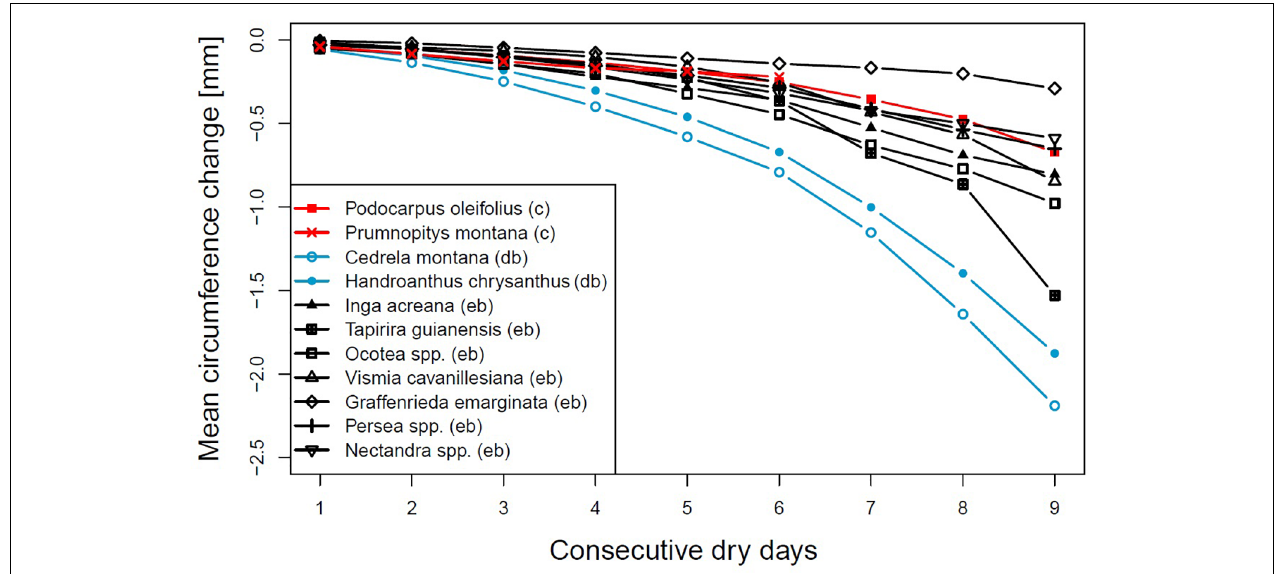
FIGURE 1 | Mean circumference changes after consecutive rainless days for different genera or species. Evergreen broadleaved (eb, black), coniferous (c, red) or deciduous broadleaved (db, lightblue).